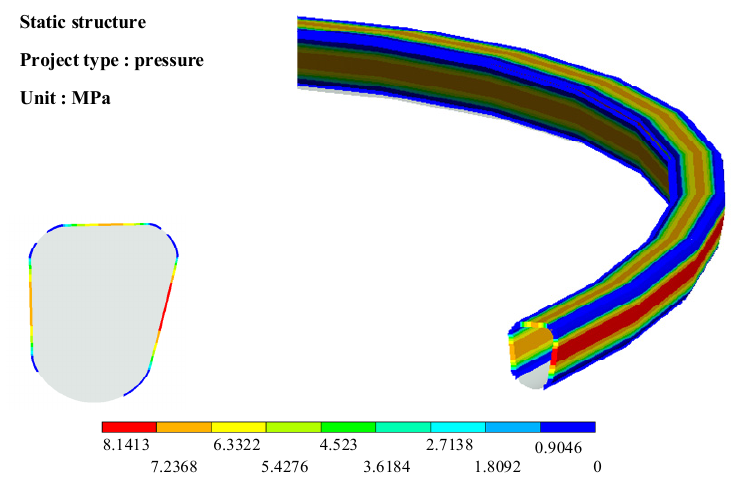
Figure 8. Nephogram of O-ring von Mises stress under no pressure.